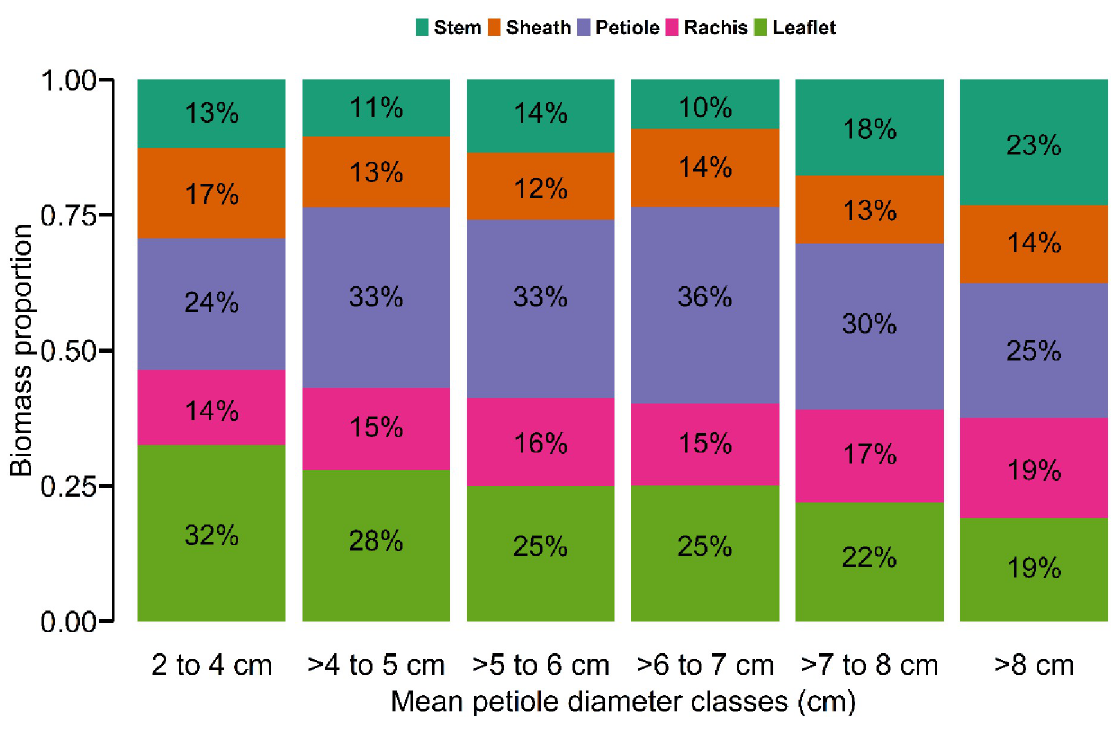
Fig 3. Aboveground biomass distribution among the stem, sheath, petiole, rachis and leaflet for each mean petiole diameter class for the 90 R . laurentii individuals destructively sampled.